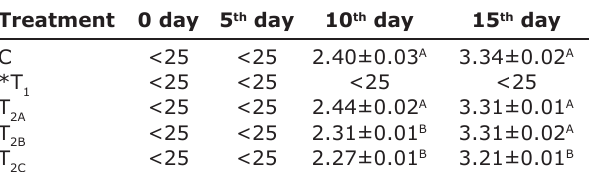
Table-6: Effect of CS and LS on TPC (log CFU/g) of pork sausage at different storage periods (mean±SE). Treatment 0 day 5 th day